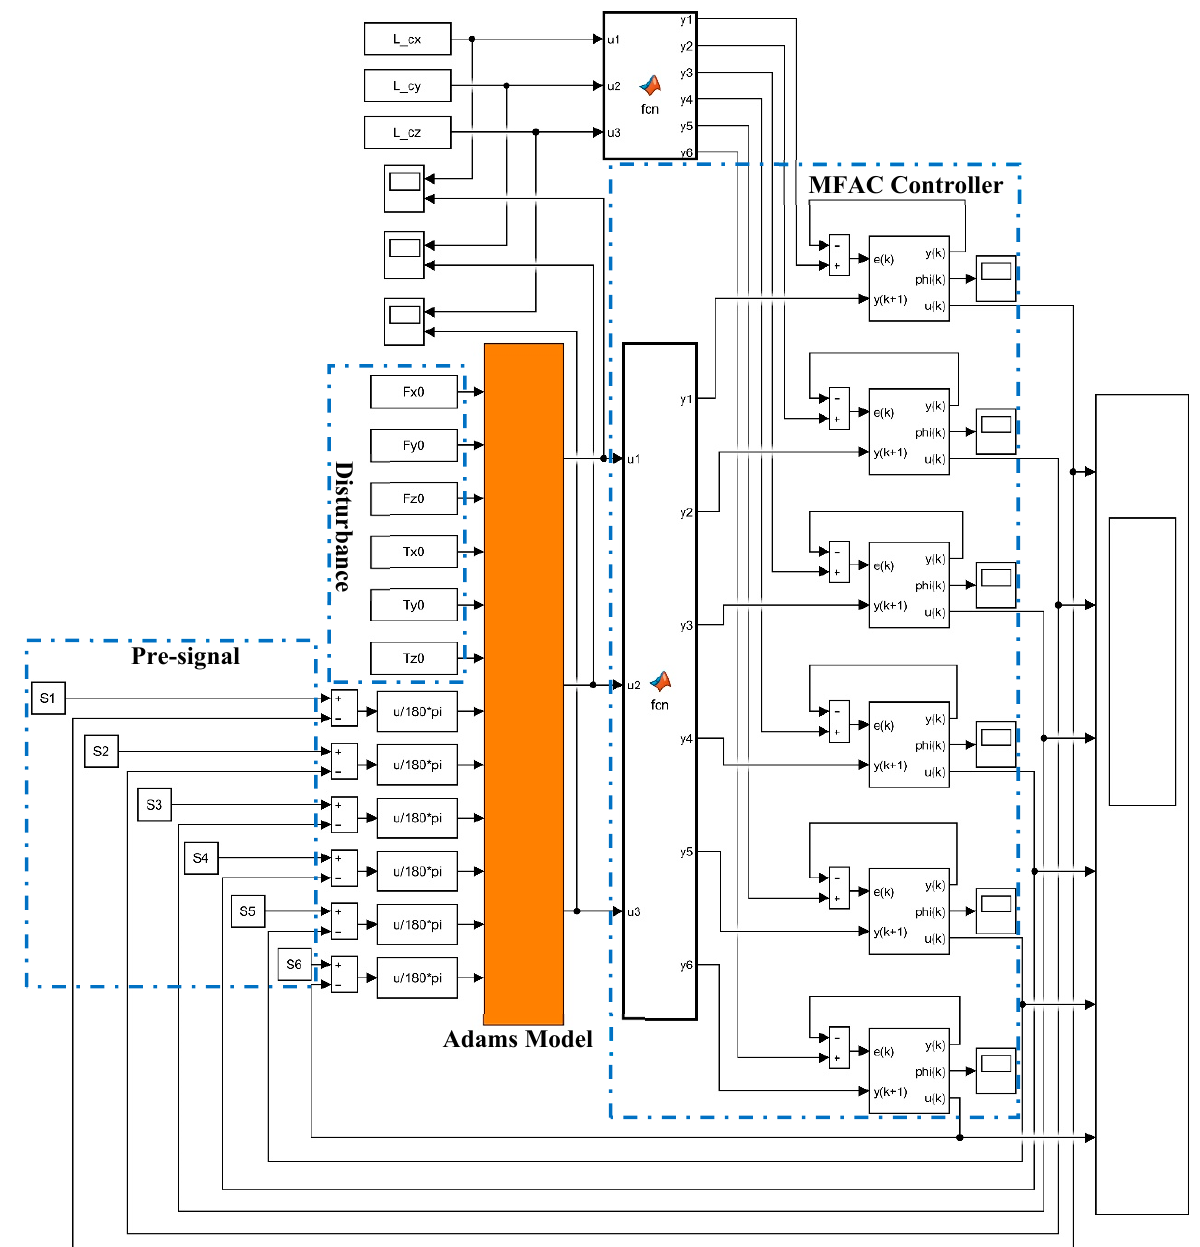
Figure 6. MFAC Based Simulink Controller Model. The kernel of the MFAC controller is shown in Figure 7.